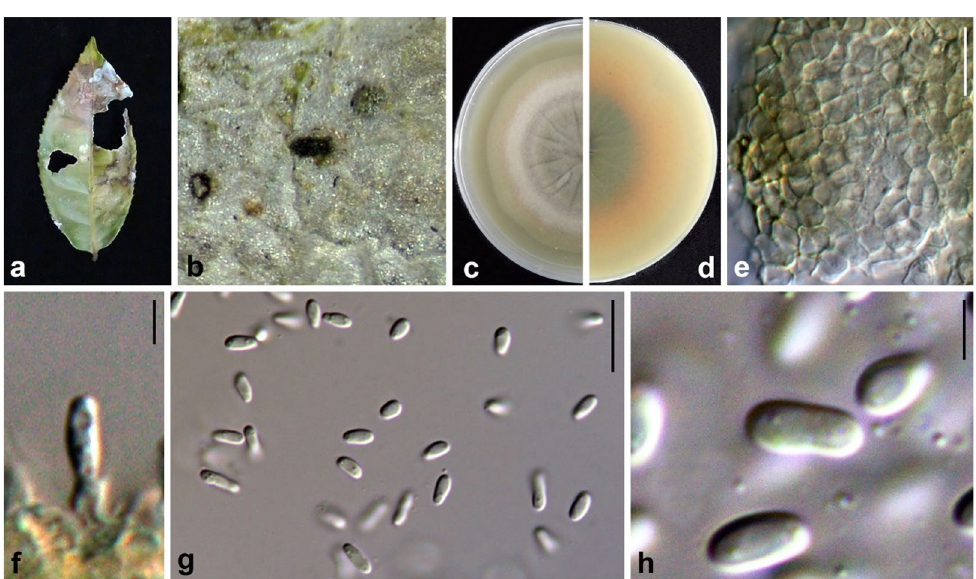
Figure 4. Neoshiraia taiwanensis (NTUH17-031, holotype ). ( a ) Leaf lesions. ( b ) Conidioma on host surface. ( c , d ) Cultures on Emerson agar, from above and below. ( e ) Conidiomatal wall. ( f ) Conidiogenous cells and developing conidia. ( g , h ) Conidia. Scale bars: ( e , g ) = 10 μm, ( f , h ) = 2.5